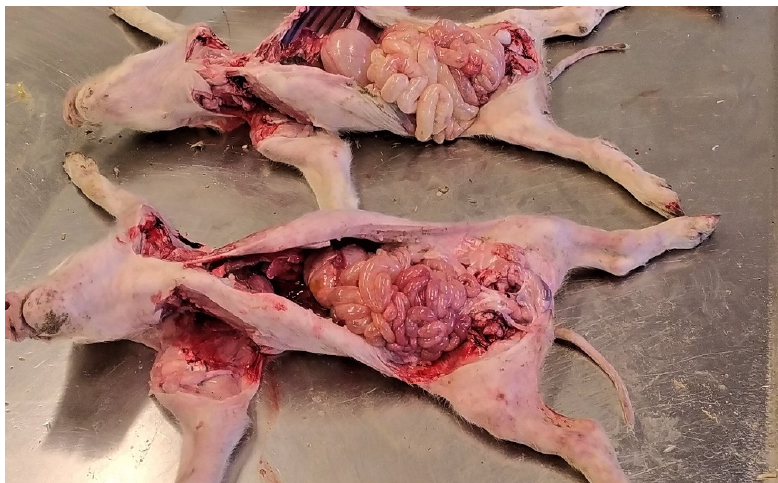
Figure 7. Suckling piglets suffering from colibacillosis. The small intestine is dilated, meteoric and hyperaemic.